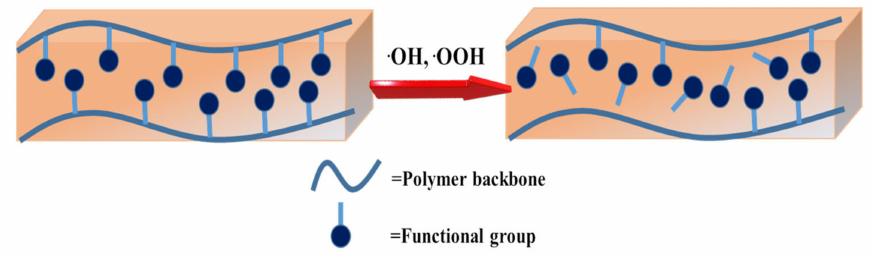
Figure 8. Mechanism showing degradation of SP-PMPS by Fenton’s